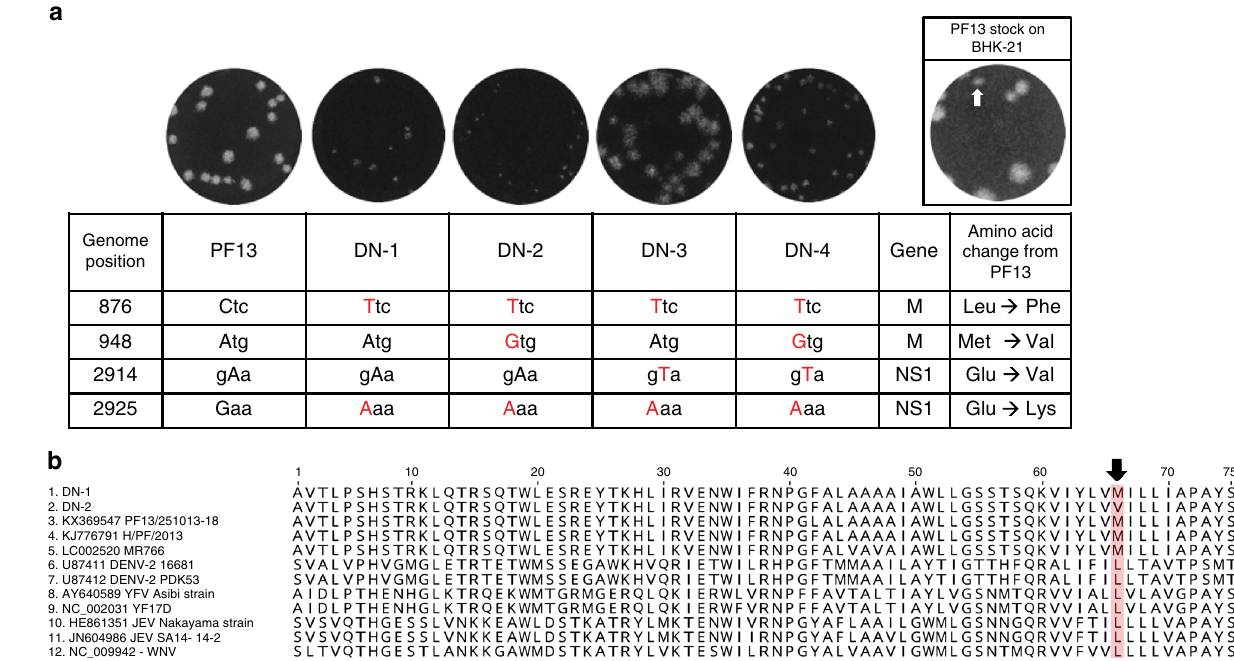
Fig. 1 Infectious clone-rescued small-plaque ZIKV and unique M protein mutation. a Plaque phenotype on Vero cells and mutations of infectious clone- derived ZIKV, based on sequences of small-plaque variants (white arrow) puri fi ed from C6/36-derived PF13 stock. b The amino acid sequences of various ZIKV strains of different lineages (Asian and African) and both wild-type and vaccine strains, if available, of various mosquito-borne fl aviviruses were aligned and the unique M66V mutation in DN-2 is highlighted in red and indicated with an